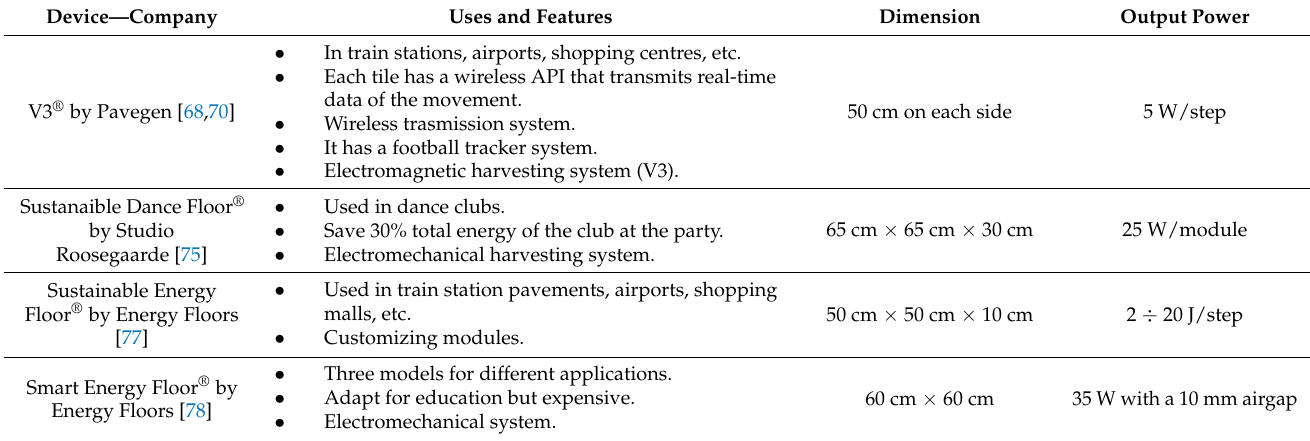
Table 4. Summary and performance comparison of presented smart floor devices in terms of trans- duction mechanism, main features, size and produced output